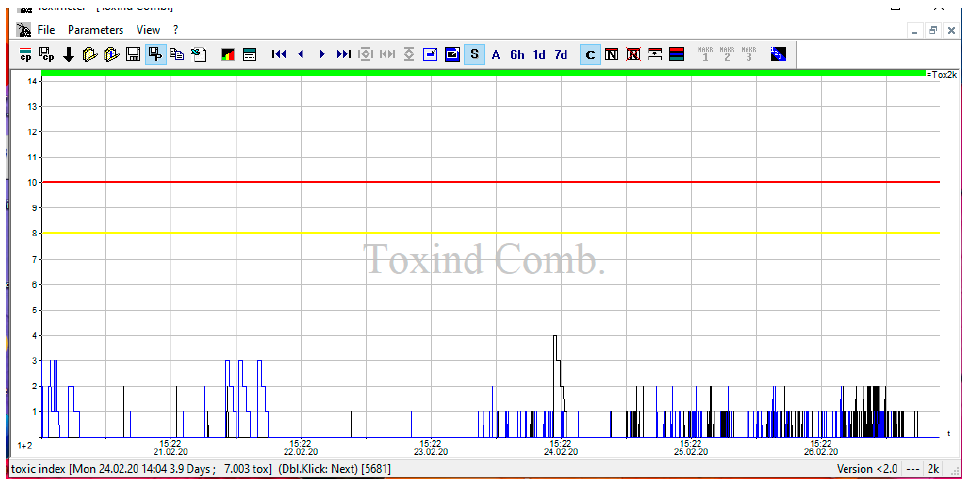
Figure 16. Toxic index combined of analysis from 20 to 27 February 2020.